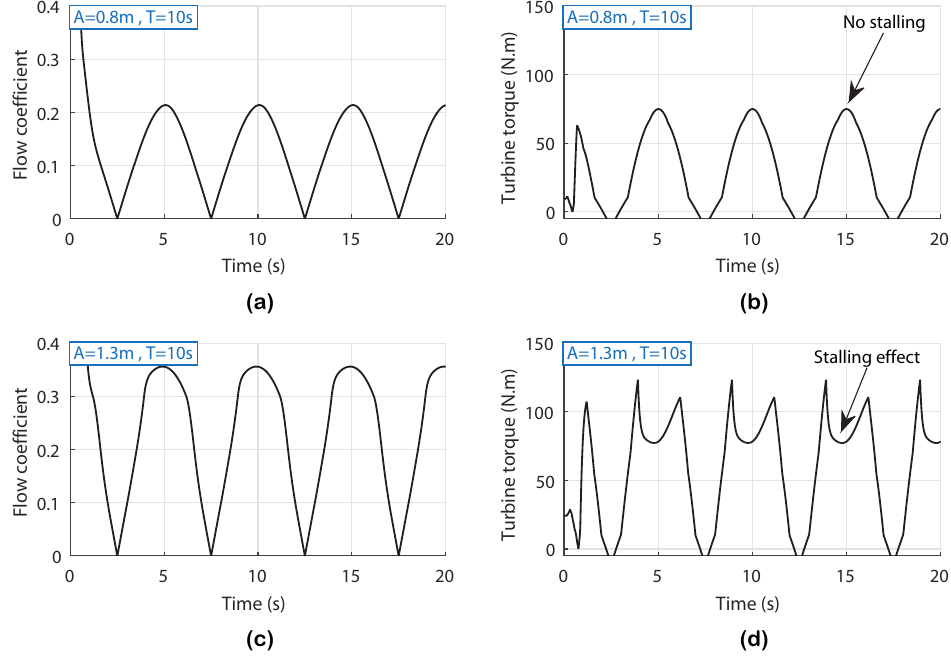
Figure 4. Uncontrolled OWC operation with two different sea conditions. ( a ) Flow coefficient for wave amplitude 0.8 m. ( b ) Turbine torque for wave amplitude 0.8 m. ( c ) Flow coefficient for wave